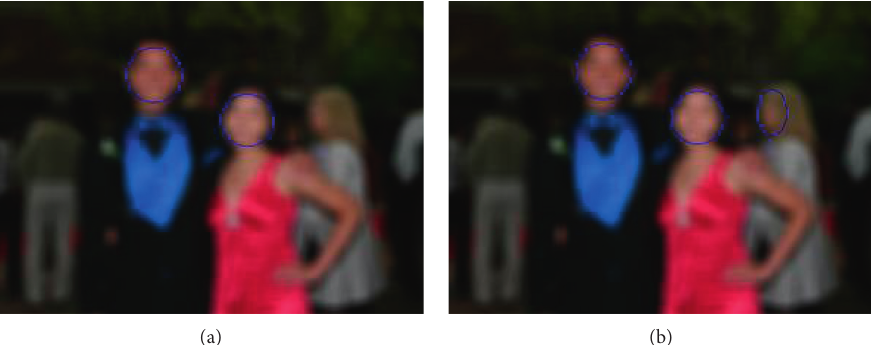
Figure 12: Detection on the blurred image by the CNN and MSDNN methods. (a) Results by the CNN method. (b) Results by the MSDNN